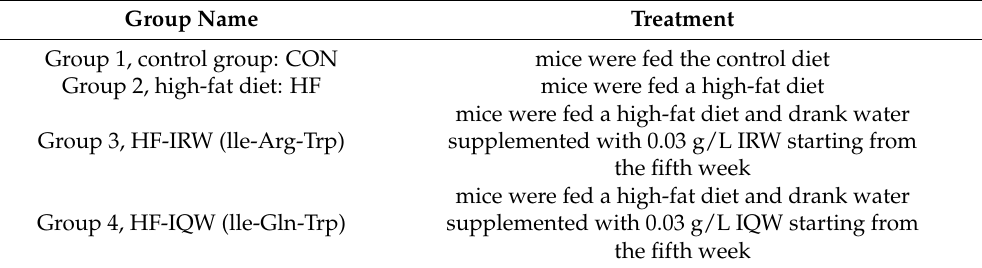
Table 1. Group name and